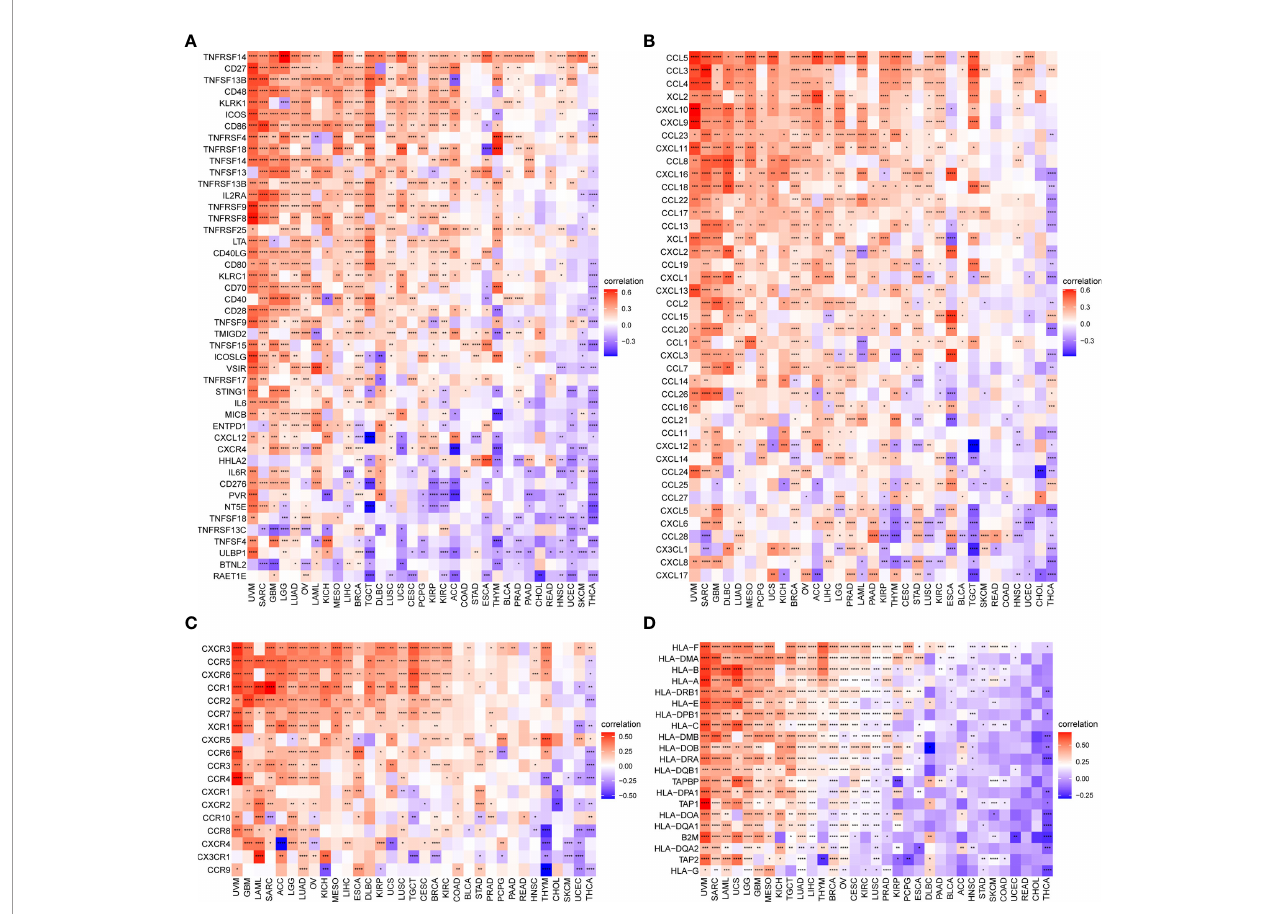
FIGURE 12 | Correlation between TRP score and immune-related genes. (A – D) . Correlation of TRP score with (A) immune-activating genes, (B) chemokines, (C) chemokine receptors, or (D) MHC genes in pan-cancer. * P < 0.05, ** P < 0.01, *** P < 0.001, **** P < 0.0001.